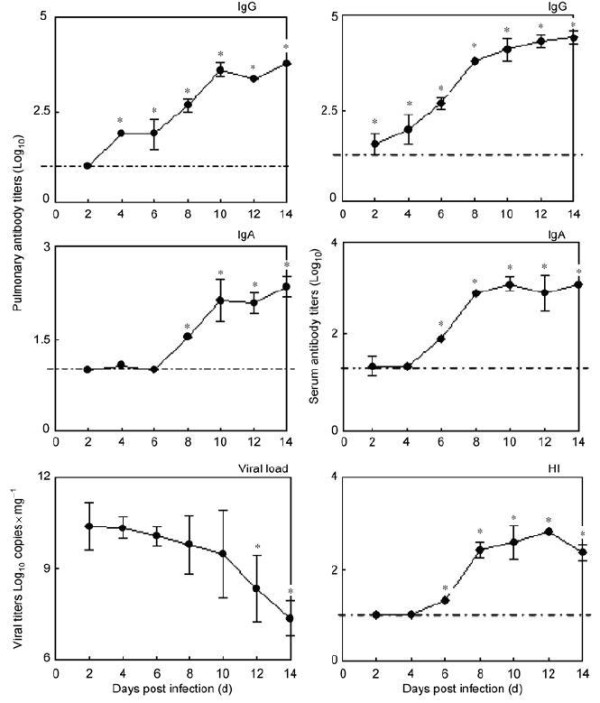
The dynamics of pulmonary viral load and antibody response in lungs and serum in mice after fatal dose (5 × 105 p.f.u.) of A/PR/8/34 (H1N1) virus infection per time-point. HI, haemagglutination inhibition assay. Mice without infection were used as the control group. The dotted lines represented the results of control group. I bars represented standard deviations. *p < 0.05, compared with control group.